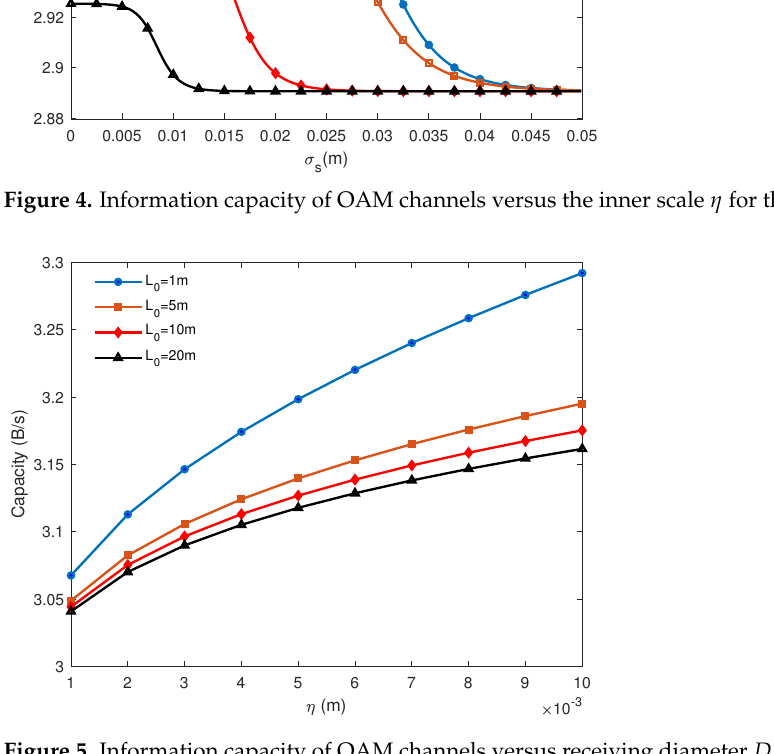
Figure 5. Information capacity of OAM channels versus receiving diameter D and pointing